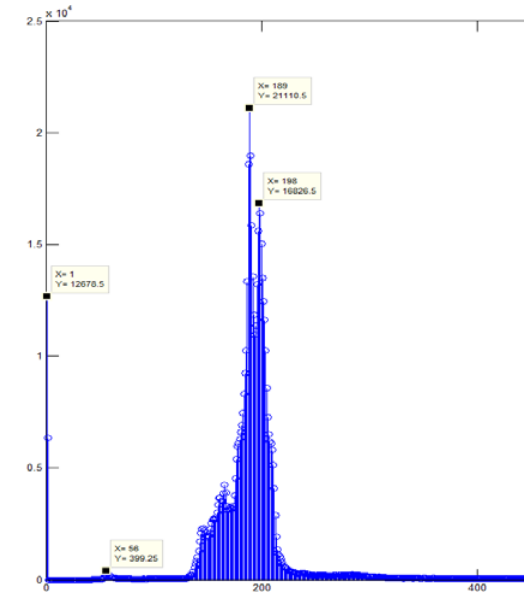
Figure 4. Histogram of the modified DEM